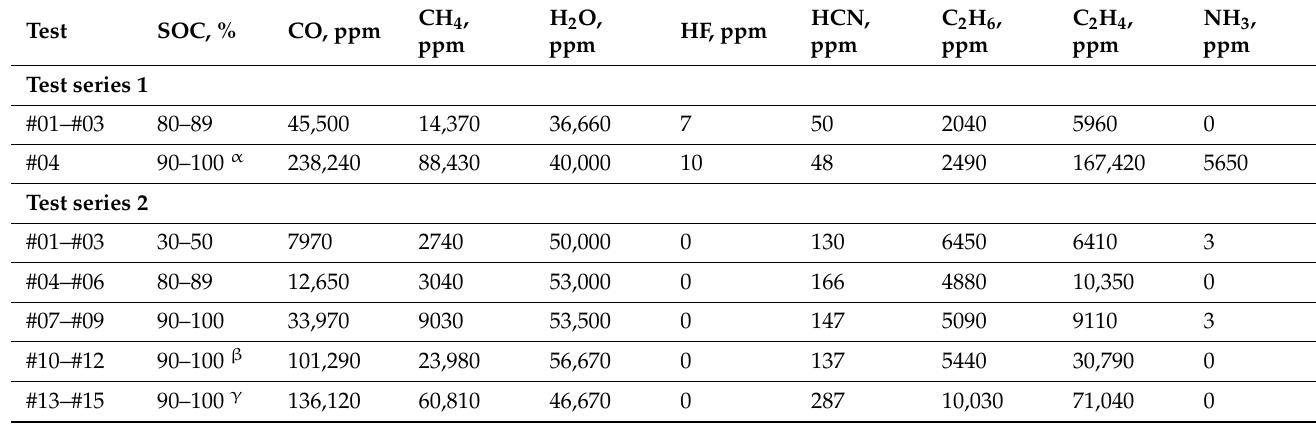
Table 2. Concentration of gas components released during thermal